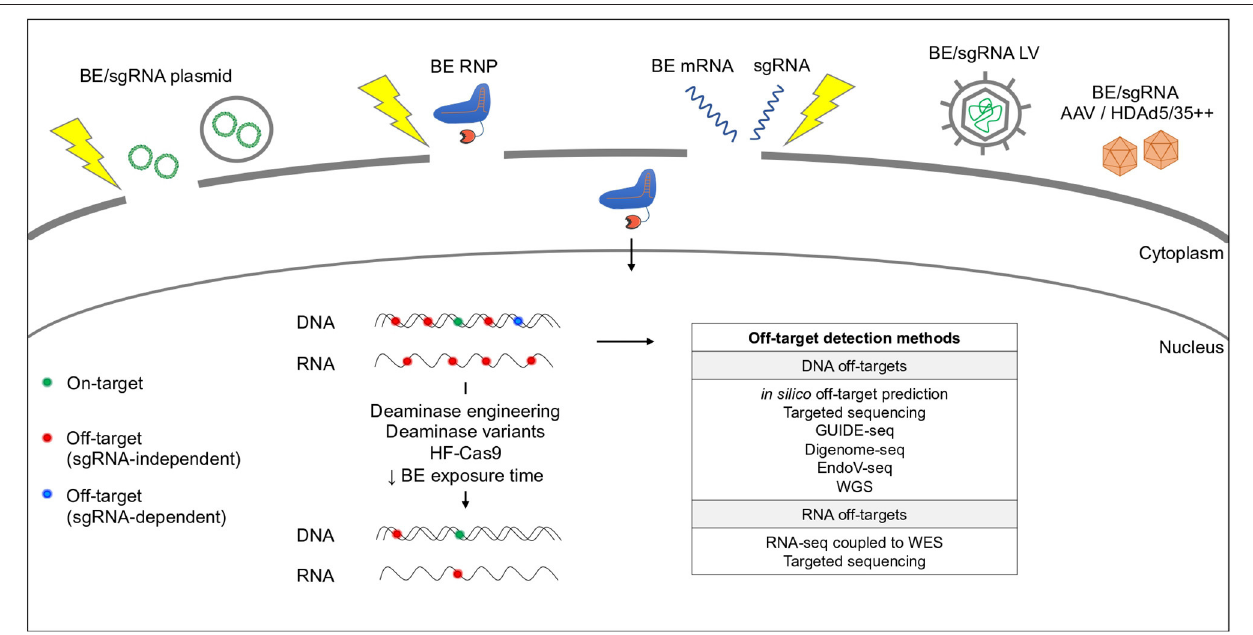
FIGURE 3 | Base editing delivery systems and potential off-target activity. BEs are delivered by plasmid chemical transfection (e.g., lipofectamine) or electroporation (yellow thunder), RNP or mRNA electroporation or LV/AAV transduction. BEs can cause RNA and DNA off-target effects in a sgRNA-independent (red dots) or -dependent (blue dots) manner. Off-target activity can be reduced by modifying the deaminase and/or the Cas9. Current methods used to predict and detect DNA and RNA off-targets are indicated in the table. WGS, Whole Genome Sequencing; WES, Whole Exome